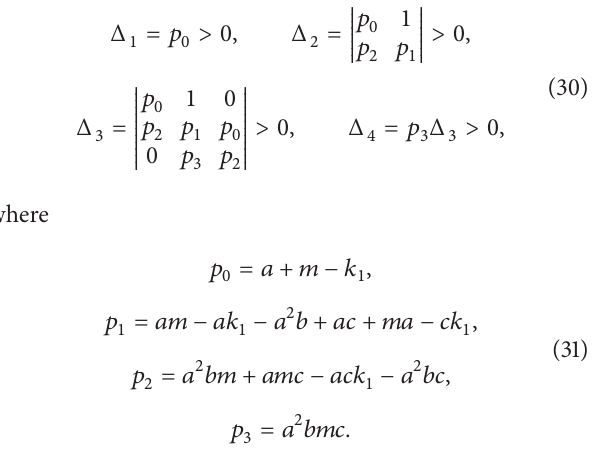
Let the damping coefficient 𝑚 = 0.5 . The washout filter is designed